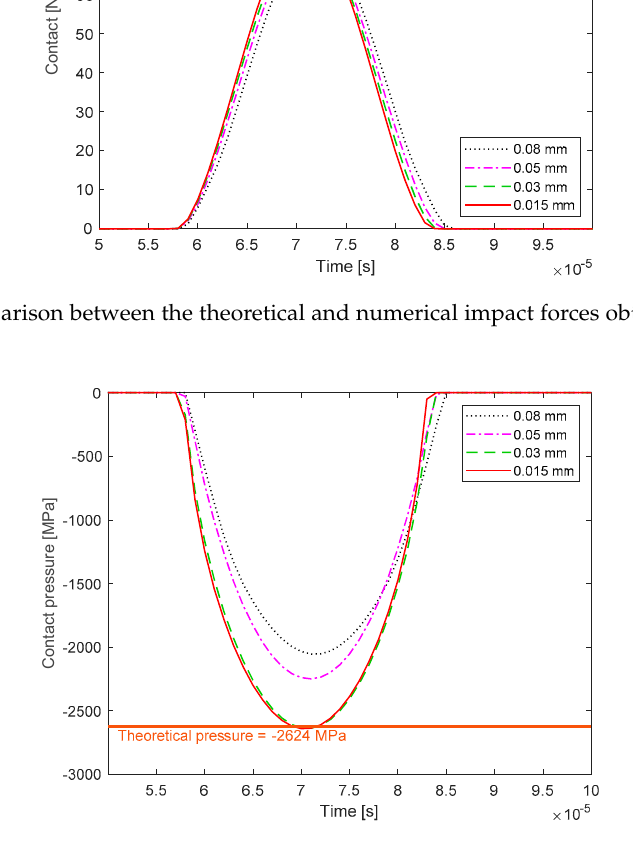
Figure 9. A comparison between the theoretical and numerical contact pressure obtained for different mesh sizes.